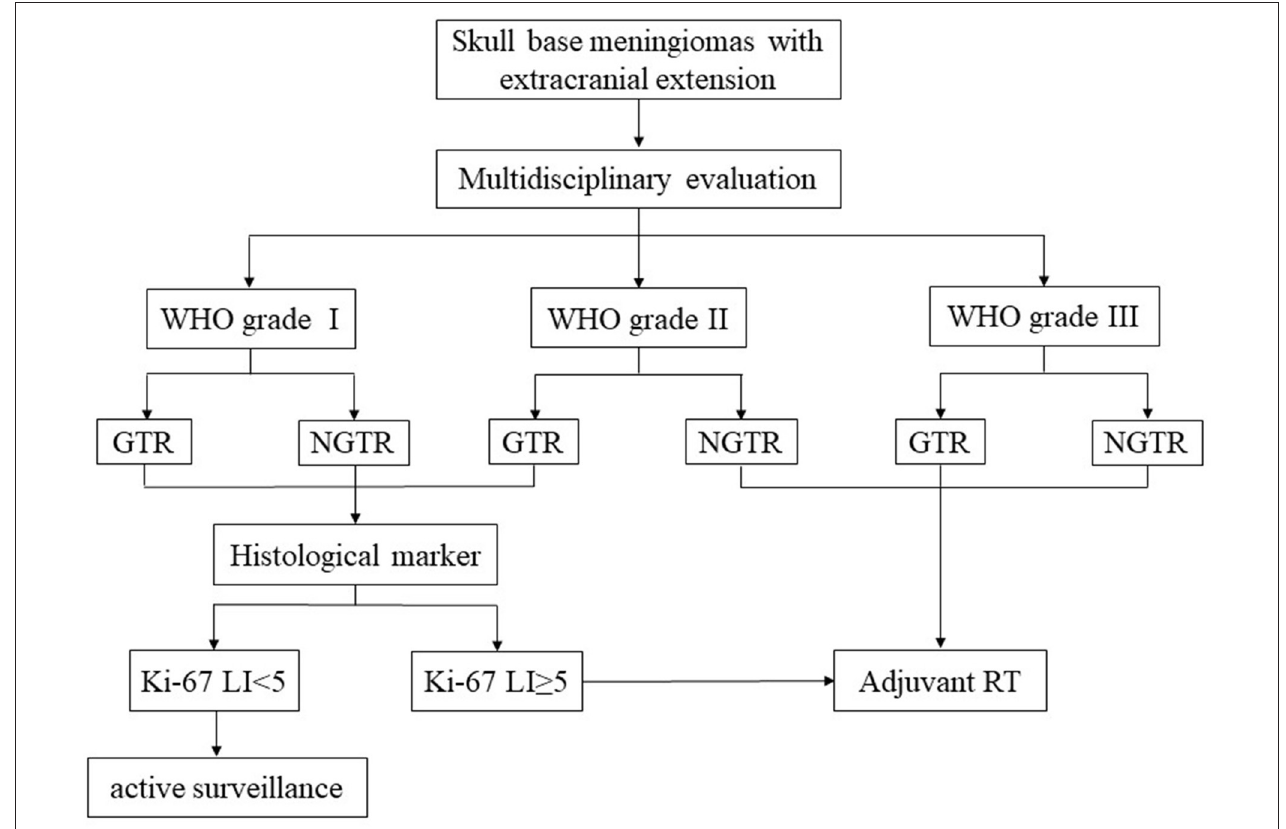
FIGURE 10 | Treatment algorithms for skull base meningiomas with extracranial